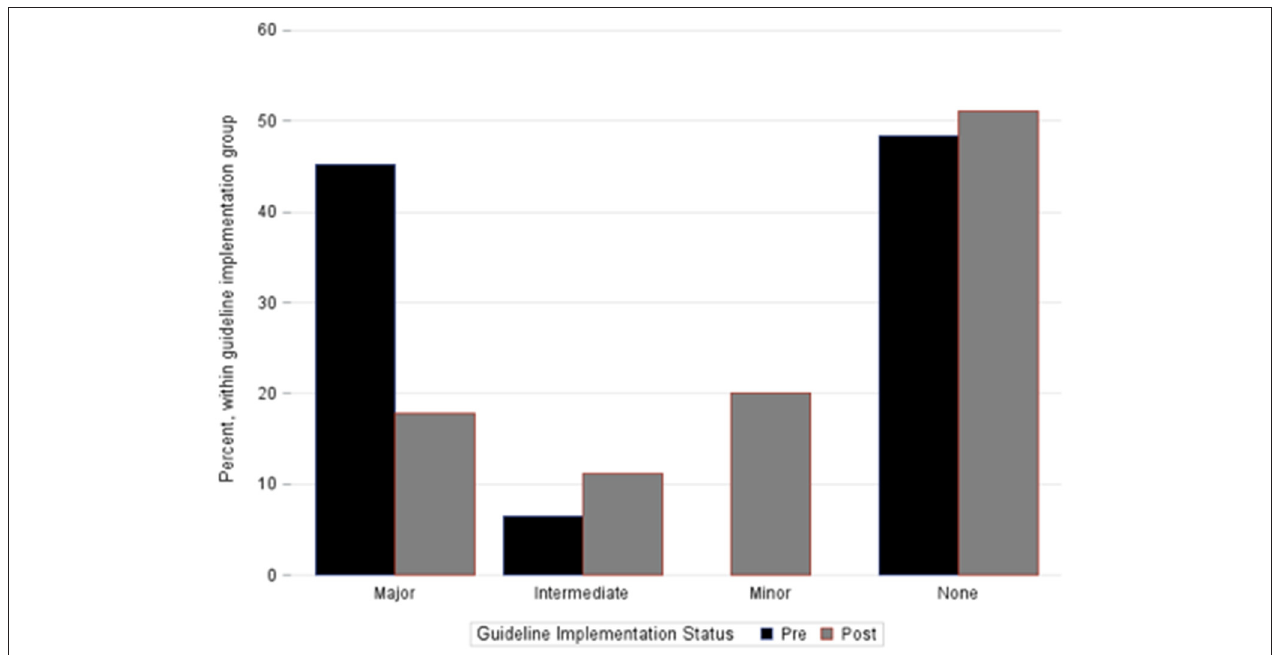
FIGURE 1 | Percentage of patients within each bleeding category severity cohort. Bar groupings represent the most severe hemorrhagic complication each individual patient suffered during the ECMO course. No patients in the pre-implementation cohort experienced only a minor hemorrhagic complication. Fisher’s exact test, p =